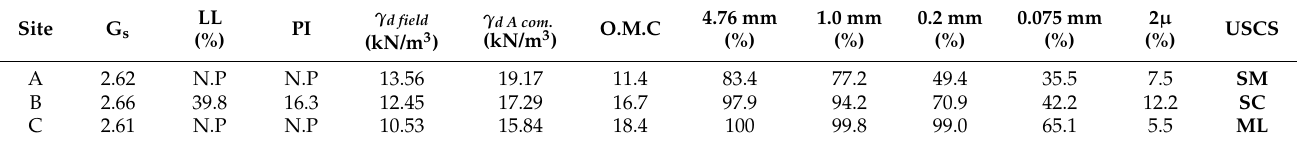
Table 1. Mechanics and physical properties of soils on site A, site B, and site C.